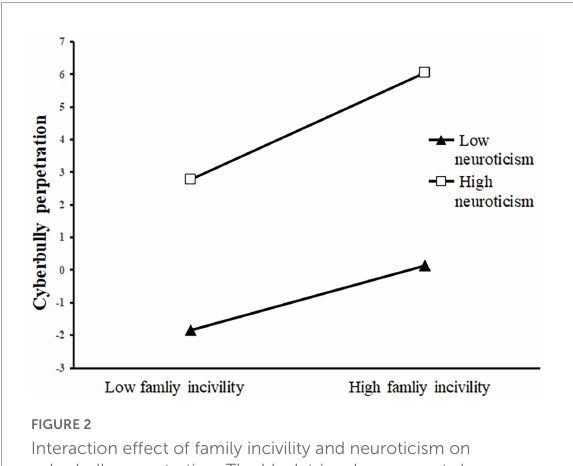
FIGURE2 Interaction effect of family incivility and neuroticism on cyberbully perpetration. The black triangle represents low neuroticism and the white square represents high neuroticism.